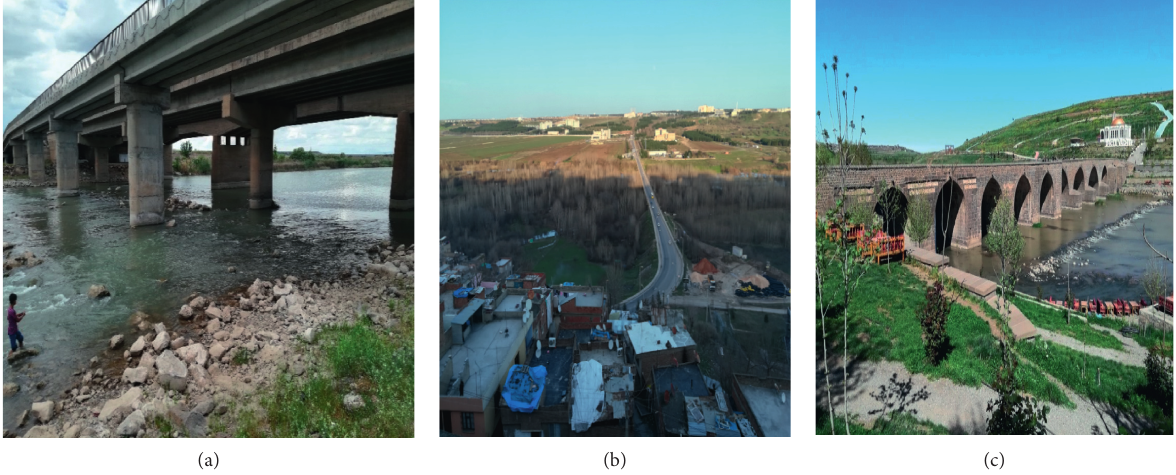
Figure 4: (a) Sadi Bridge, (b) University Bridge, and (c) Ten-Eyed Bridge views.